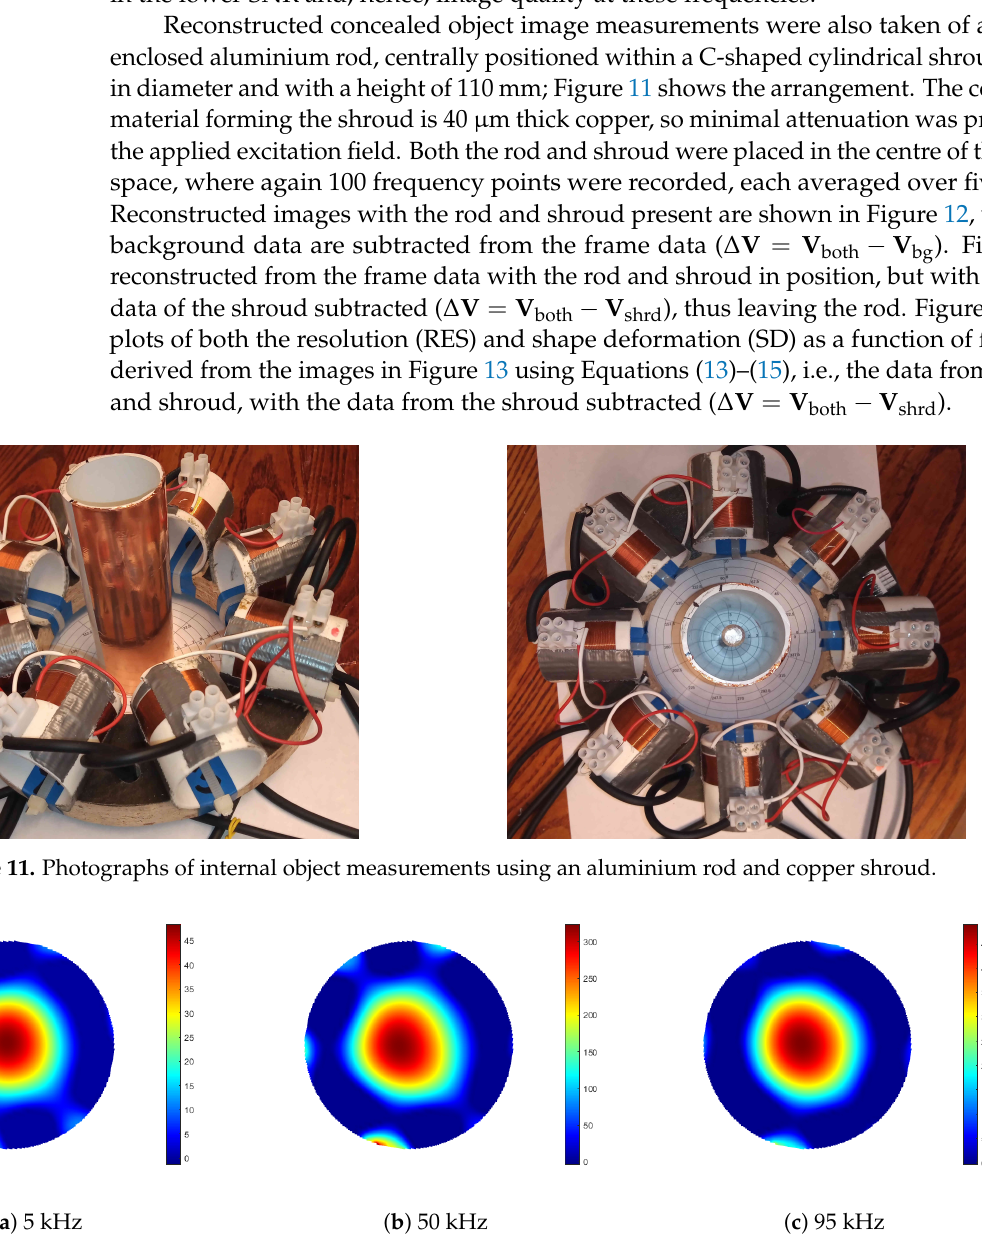
Figure 12. Reconstructed image measurements of aluminium rod partially concealed in a copper shroud, acquired using 5, 50 and 95 kHz excitation field frequencies. Image constructed from frame data of both rod and shroud present in the sample space ( ∆ V = V both − V bg